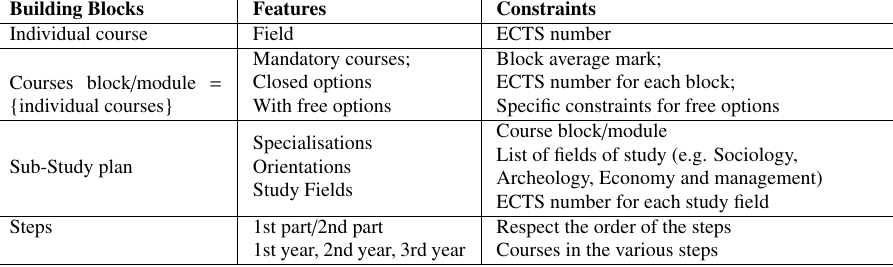
Table 4: Building blocks - Study Plan